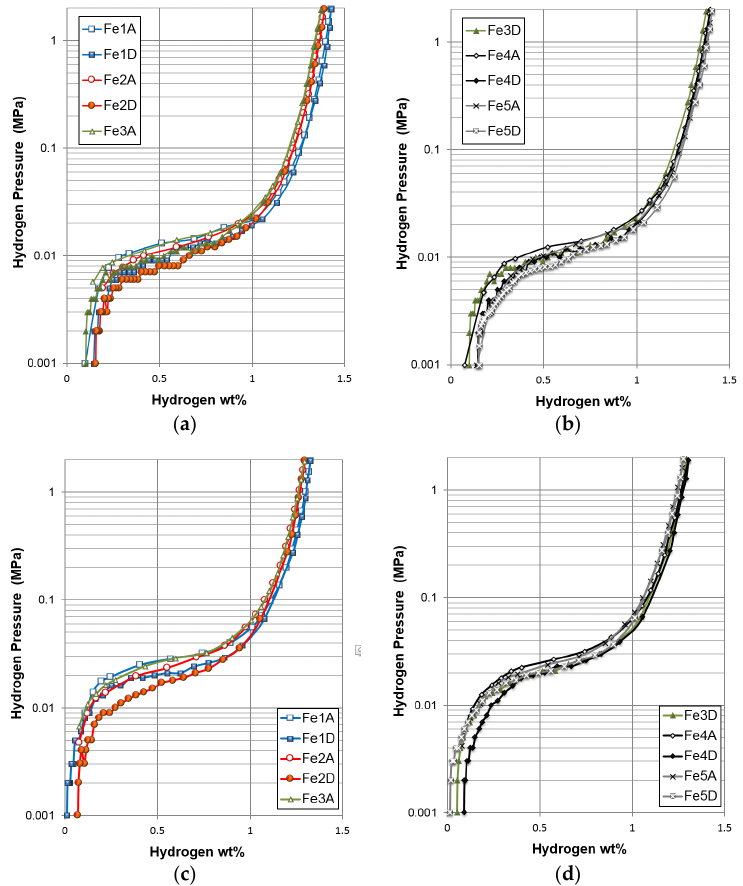
Figure 6. Pressure-concentration-temperature (PCT) isotherms measured at ( a , b ) 30 and ( c , d ) 45 °C for alloys Fe1–Fe5. A and D denote absorption and desorption, respectively. The plateau region has been expanded in the inset.